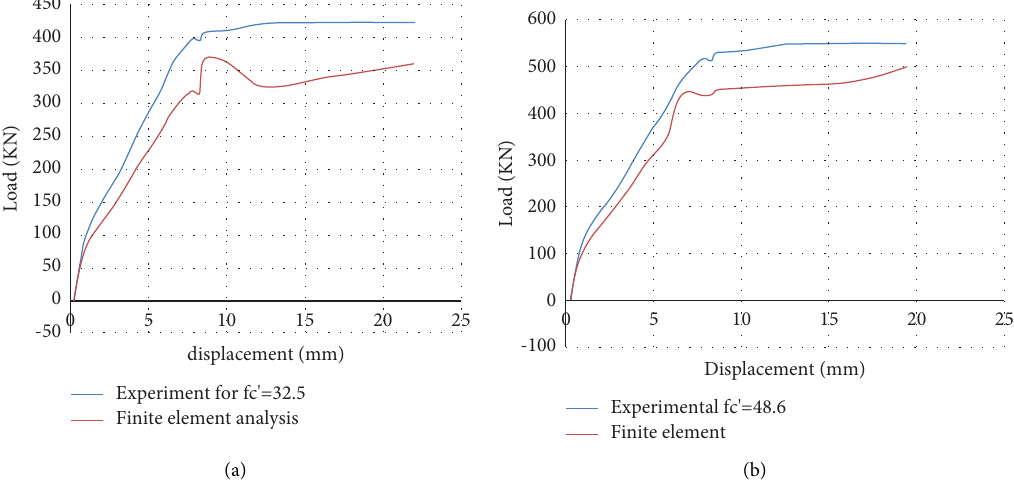
Figure 3: Load vs displacement result reinforced dapped-end beam at (a) fc ʹ equal to 32.5 and (b) fc ʹ equal to 48.6.